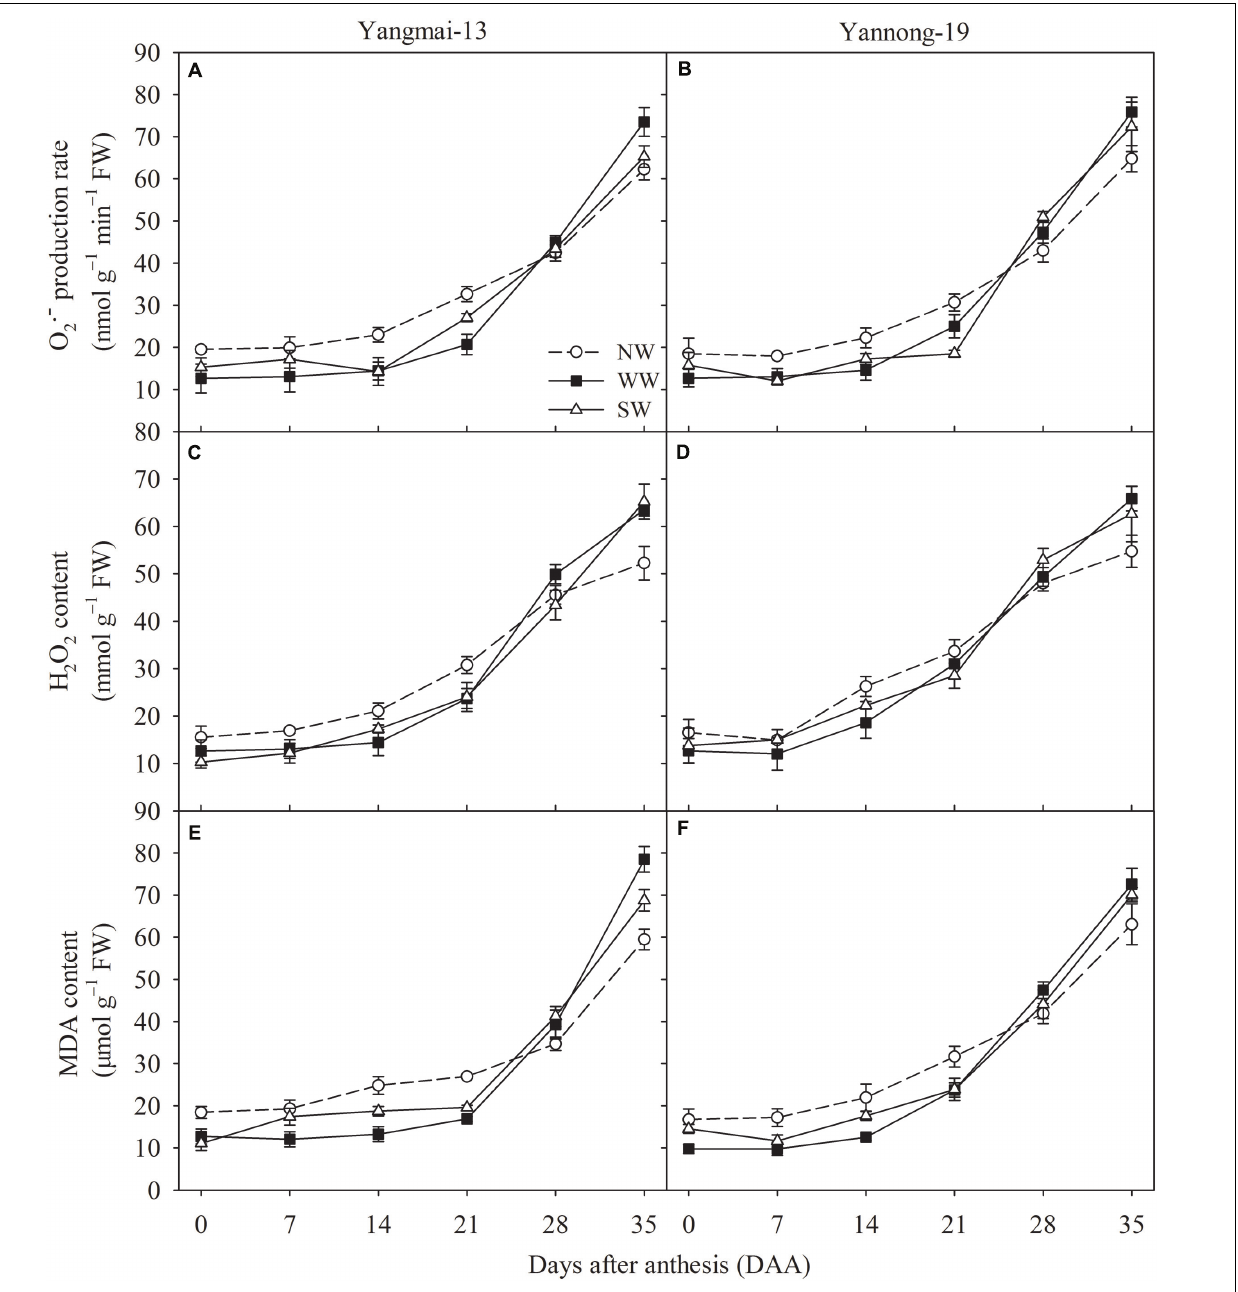
FIGURE 4 | Superoxide anion radical (O •− 2 ) production rate, hydrogen peroxide (H 2 O 2 ) content, and malondialdehyde (MDA) content as affected by winter (WW) and spring (SW) night-warming in the flag leaves of Yangmai-13 (A,C,E) and Yannong-19 (B,D,F) after anthesis during 2013–2014. NW refers to the no warming control. The data are the means ± SE ( n =